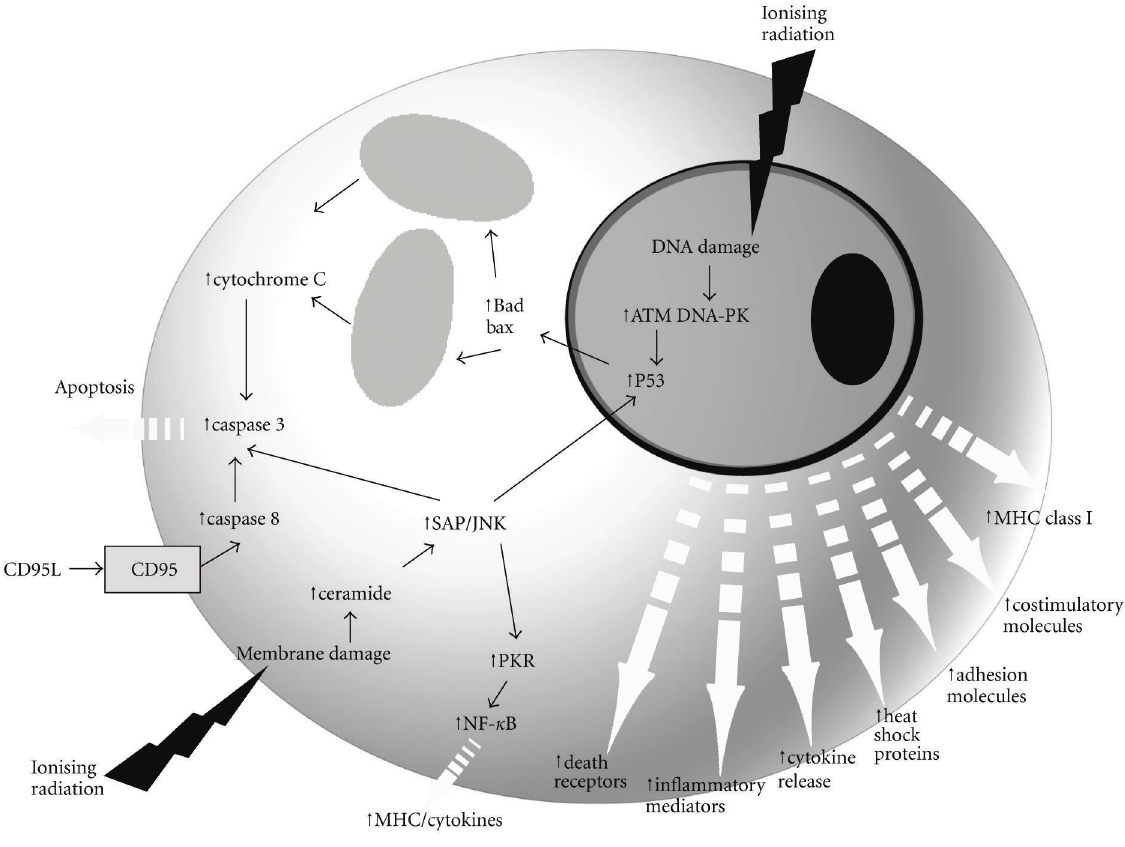
Figure 1: Confluence of SABR and Immunotherapy. Apoptosis can be initiated by SABR-induced DNA damage and upregulation of the p53 tumor suppressor gene. In addition, apoptosis can be triggered by SABR-induced damage to the cellular lipid membrane, which can induce ceramide formation and activate the SAPK/JNK signaling pathway. Thus, SAPK/JNK can upregulate PKR expression, which can induce MHC and cytokines via NF- κ B. SABR can induce cellular expression of MHC Class I, adhesion molecules, costimulatory molecules, heat shock proteins, inflammatory mediators, immunomodulatory cytokines, and death